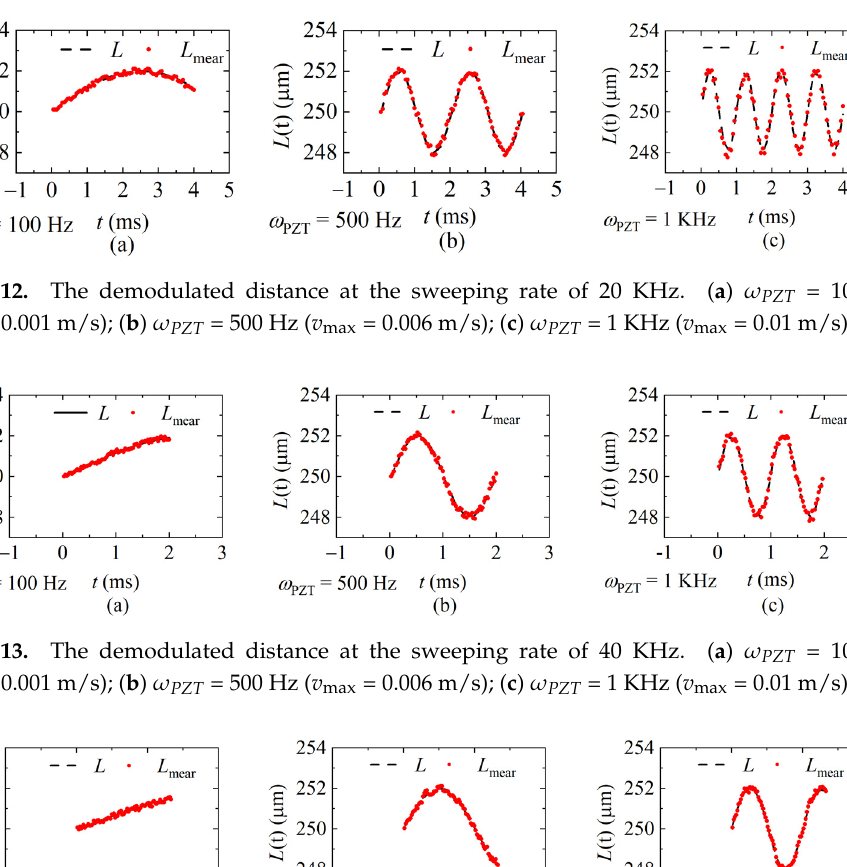
Figure 15. Errors at sweeping rates of ( a ) 20 KHz, ( b ) 40 KHz, and ( c ) 60 KHz, respectively. Figure 16. Comparison of mean values of gap measurement errors at different sweeping rates. To verify the repeatability of the proposed method, five identical dynamic experi- ments were conducted when f sweep is 20 KHz, 40 KHz, and 60 KHz. The PZT vibration- frequency ω PZT is 1 KHz in the repeatability experiments. The demodulation results were calculated and are shown in Figure 17a–c. Corresponding errors are shown in Figure 17d– f. The average standard deviation of each sweeping rate is 0.133 μ m, 0.122 μ m, and 0.123